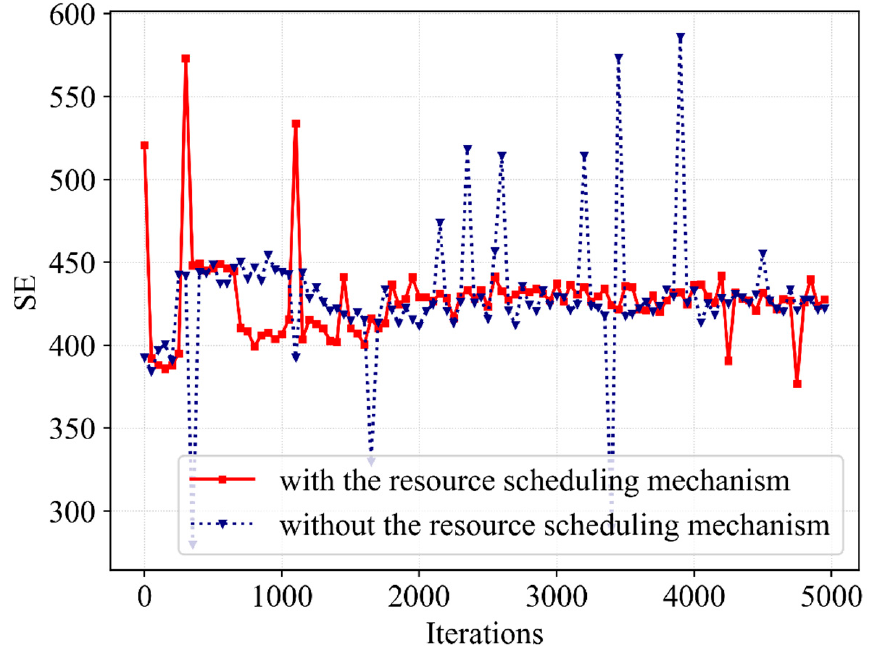
Figure 9. A comparative result of SE with and without the resource scheduling mechanism.